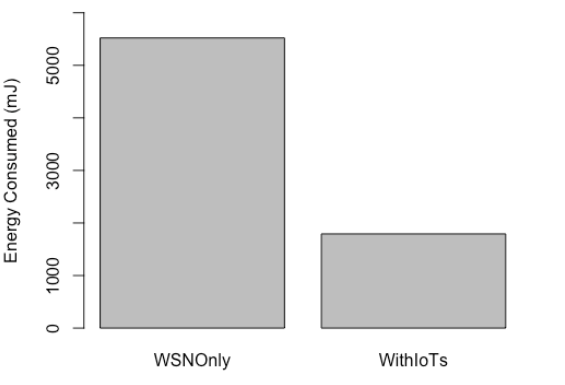
Figure 7. The energy consumption of WSN when integration platform (IT) Platform is